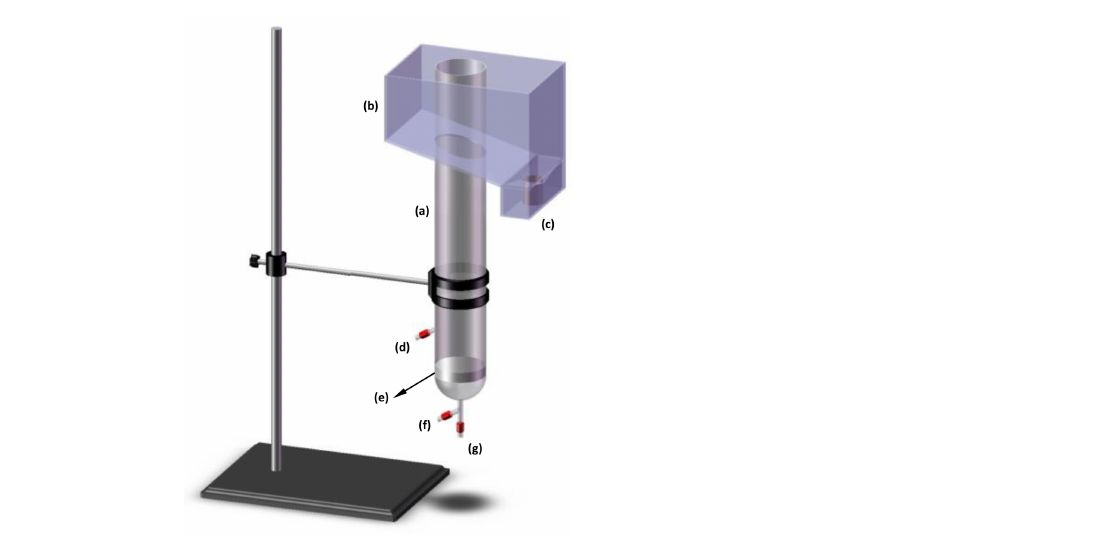
Figure 1. Schematic illustration of the used flotation column: (a) froth column, (b) froth box, (c) froth discharge gate, (d) sampling tube, (e) fritted glass sparger, (f) air inlet connected to rotameter, pressure gauge and air compressor and (g) discharge outlet for liquid diffused from